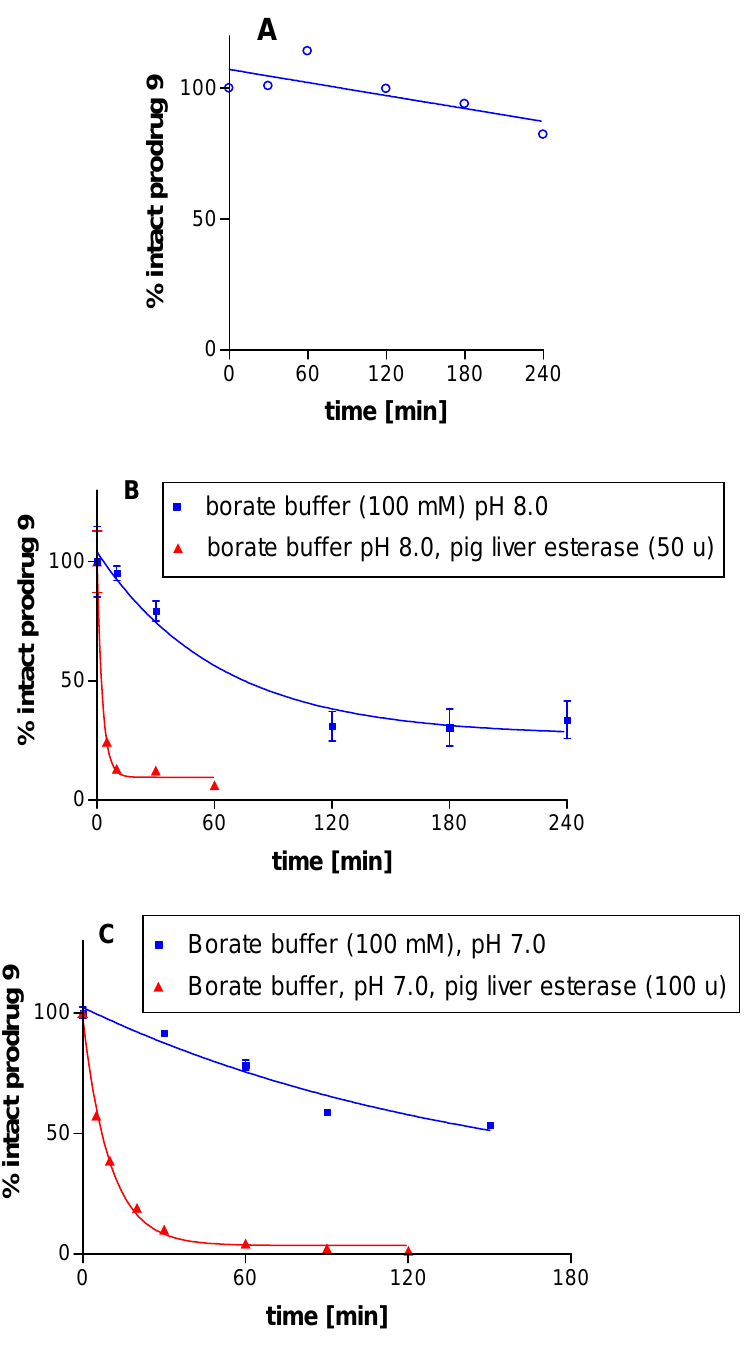
Figure 3. Stability of prodrug 9 ( A ) in artificial gastric acid (aq. HCl, pH 2, pepsin), ( B ) in borate buffer pH 8 in the presence and in the absence of pig liver esterase, and ( C ) in borate buffer pH 7 in the presence and in the absence of pig liver esterase. Data points represent results from 3 independent experiments ± SEM. In some cases the SEM value was smaller than the